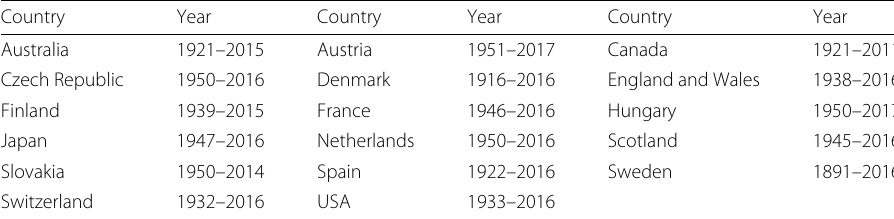
Table 1 Countries and period of data